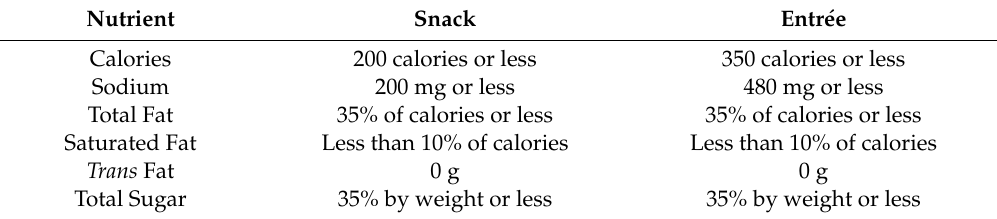
Table 2. USDA’s Smart Snacks Standards 2014–2015